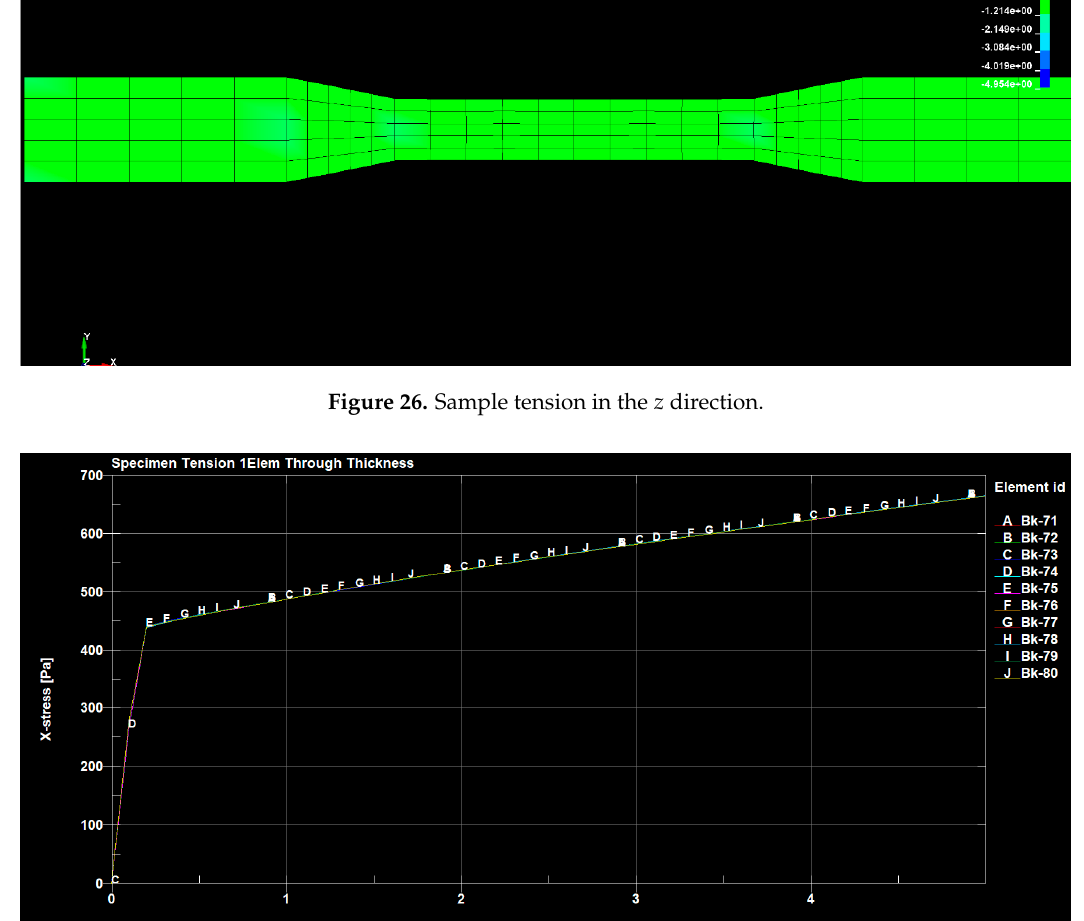
Figure 26. Sample tension in the 𝑧 direction.